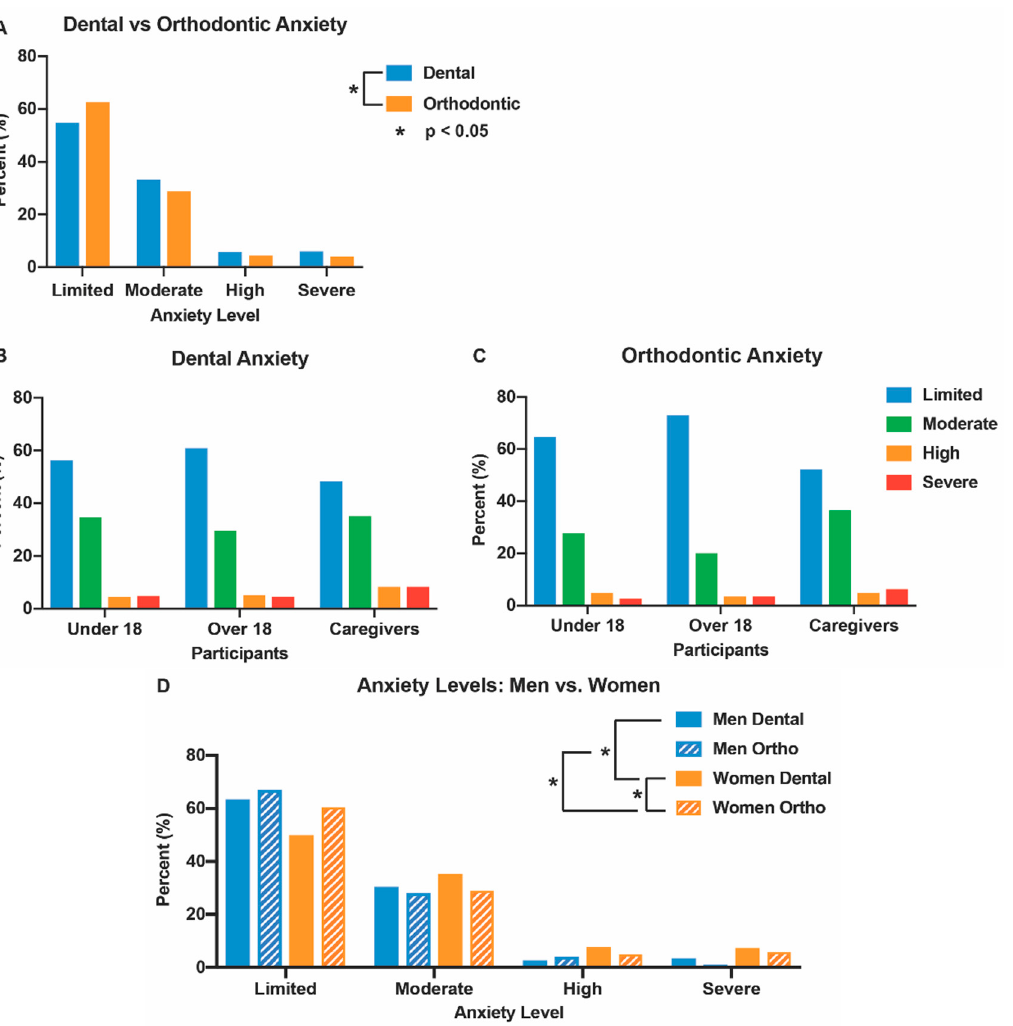
Figure 3. Dental and orthodontic anxiety. ( A ) Percentage of participants with limited, moderate, high, or severe anxiety (dental anxiety—blue; orthodontic anxiety—orange); ( B ) Participants (pa- tients under 18, patients over 18, caregivers) with dental anxiety (limited—blue; moderate—green; high—orange; severe—red); ( C ) Participants (patients under 18, patients over 18, caregivers) with orthodontic anxiety (limited—blue; moderate—green; high—orange; severe—red); ( D ) Levels of dental (solid) and orthodontic (hatched) anxiety in males (blue) and females (orange). Dental and orthodontic anxiety determined by the Corah Dental Anxiety Scale (DAS) and modified orthodontic DAS, respectively (Tables 4 and S3).